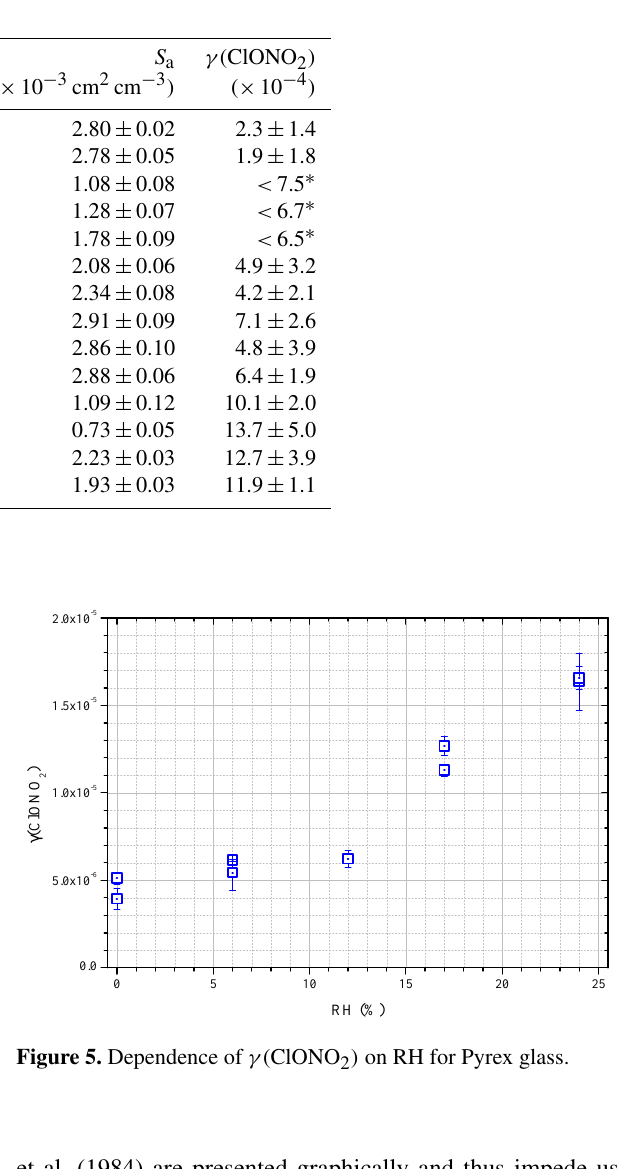
Table 2. Uptake coefficients of ClONO 2 onto SiO 2 and TiO 2 aerosol particles at different RHs. k a : loss rate of ClONO 2 onto aerosol particle surface; S a : aerosol surface area concentration; γ (ClONO 2 ) : uptake coefficients of ClONO 2 . Measurements were all carried out with initial ClONO 2 mixing ratios of several hundred ppbv.